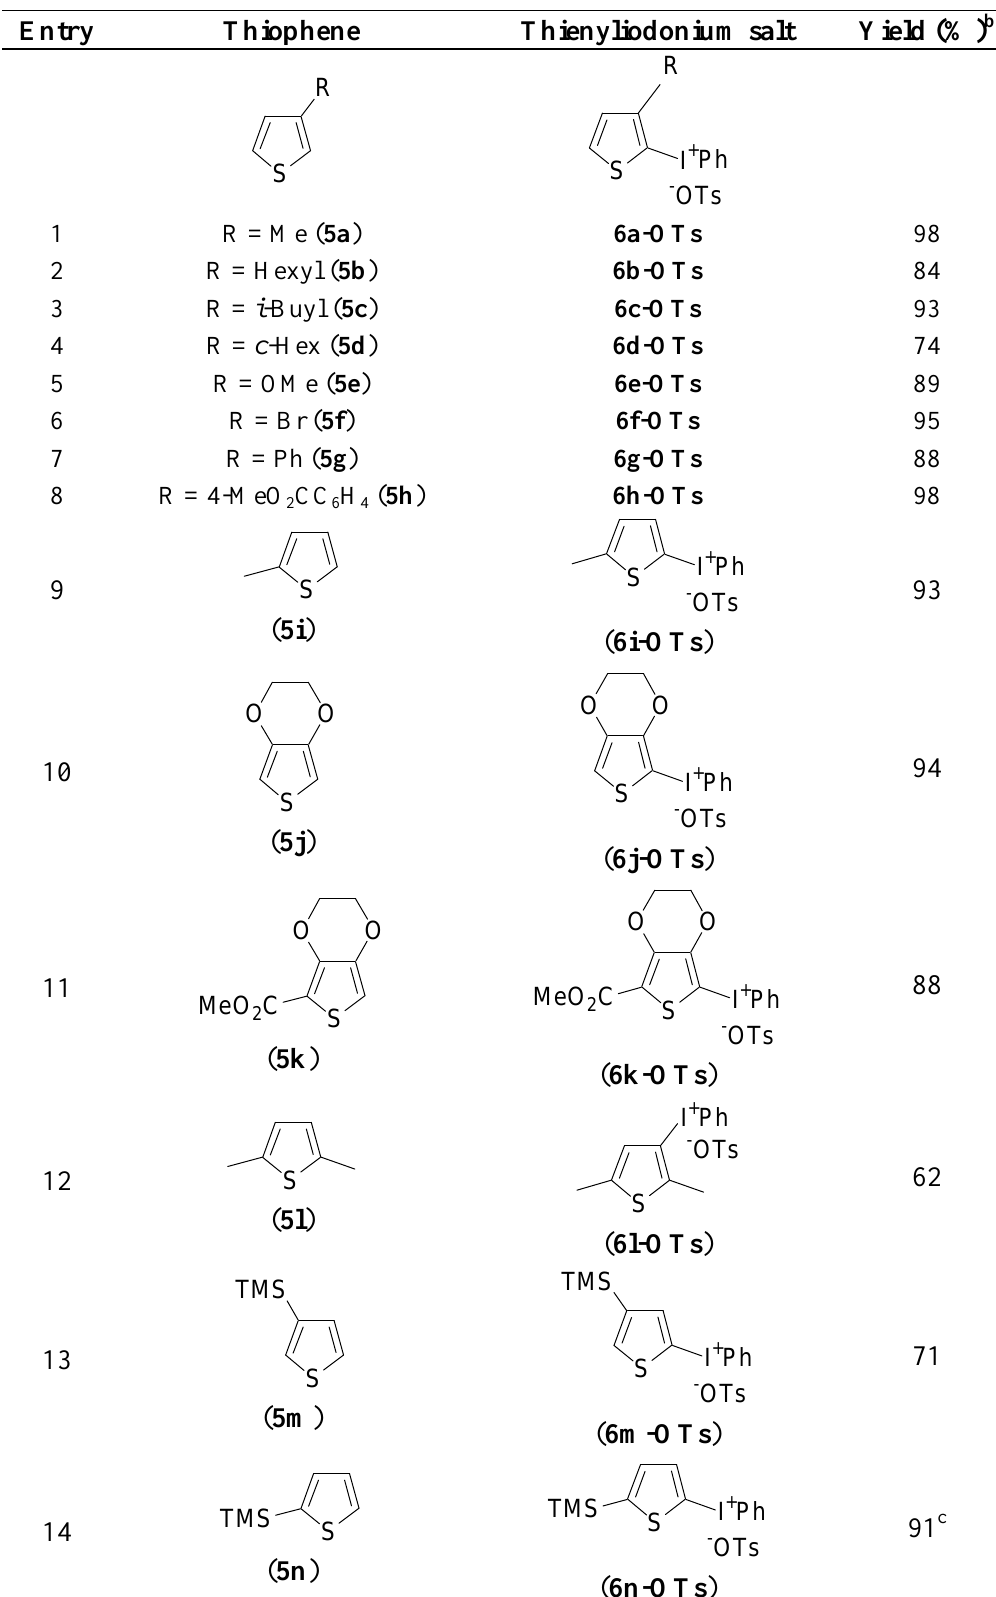
Table 1. Scope of thiophene substrates.